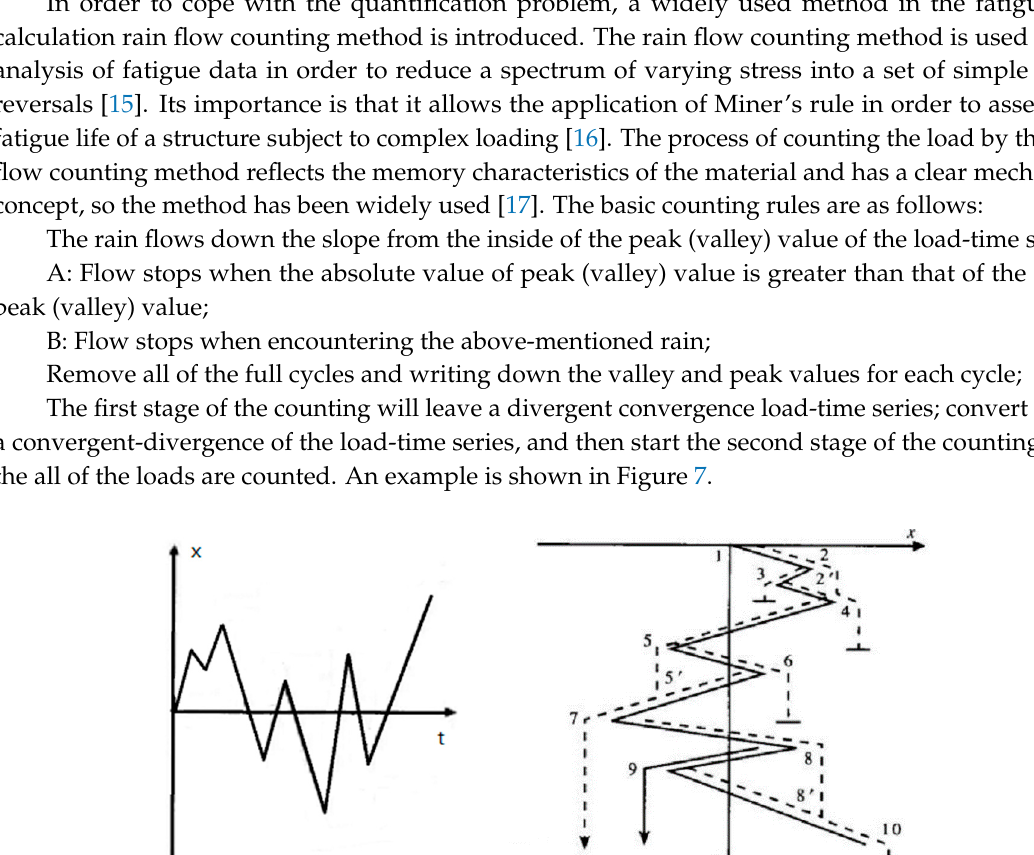
Figure 6. The original loads on the target road, ( a ) F x of the left WFS, ( b ) F y of the left WFS, ( c ) F z of the left WFS, ( d ) F x of the right WFS, ( e ) F y of the right WFS, ( f ) F z of the right WFS.